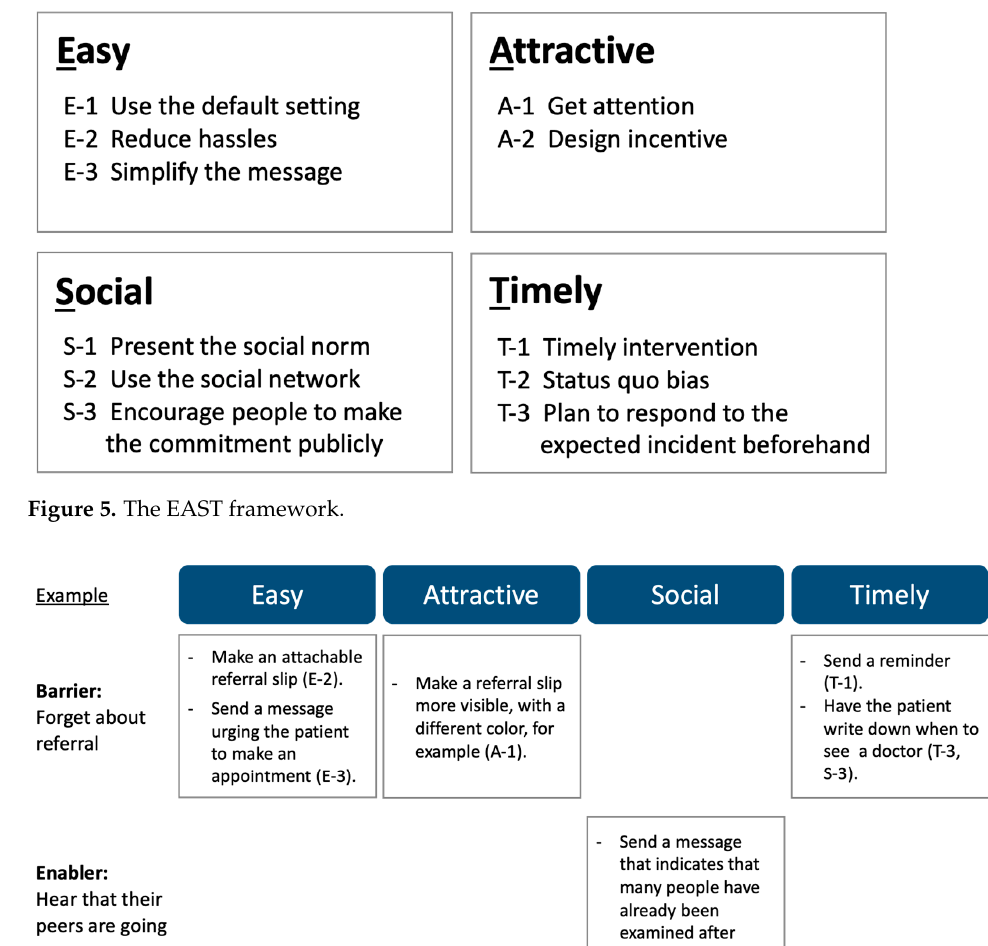
8 of 11 Figure 4. Behavioral process map and barriers/enablers: Example to increase attendance at the com- munity health center following a medical referral based on screening. Note. There are likely more barriers and enablers for each step, but only the major elements are shown in the figure. 5.3. Step 3: Design and Implement Nudge In the third step, a nudge intervention is designed and implemented to promote the target behavior. Nudges are designed to overcome barriers and take advantage of the en- ablers identified in the second step. The EAST framework can be useful in designing